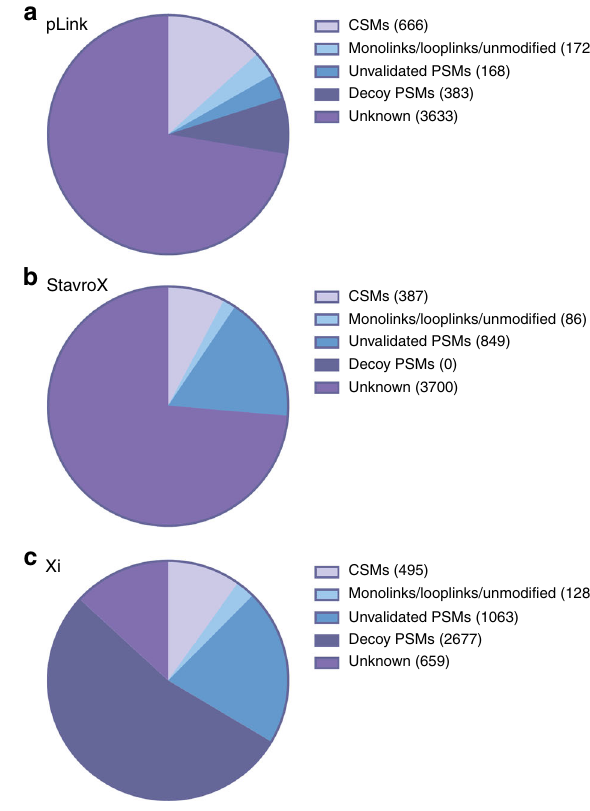
Fig. 6 number of MS2 spectra that are attributed to speci fi c features. a pLink, b StavroX and c Xi. Shown is the number of MS2 spectra annotated as CSMs, monolinks/looplinks/unmodi fi ed peptides, unvalidated PSMs with a score below the cut-off value for 5% FDR, decoy PSMs, and PSMs for which no information is known